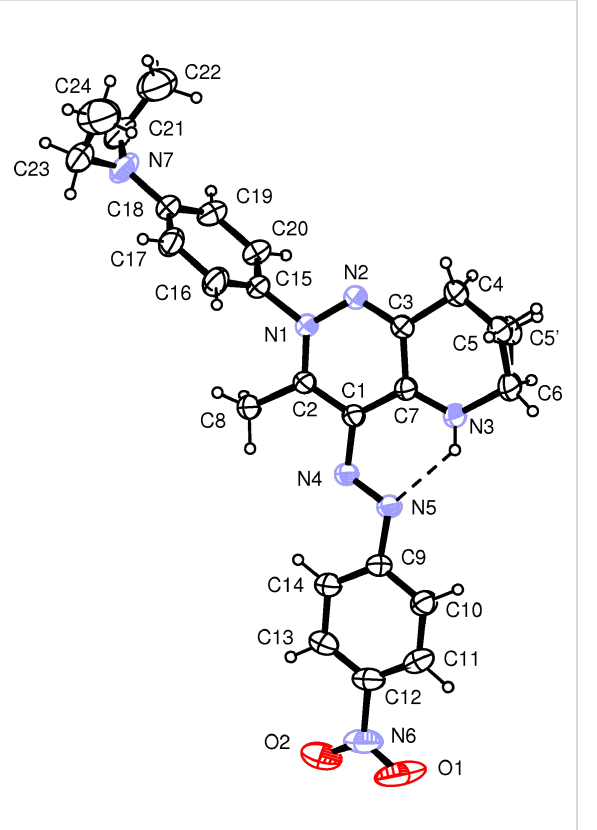
Figure 1: ORTEP view of the cation of compound 5f showing the thermal ellipsoids at 30% probability level. Both the disordered C5H 2 and C5’H 2 moieties are displayed.